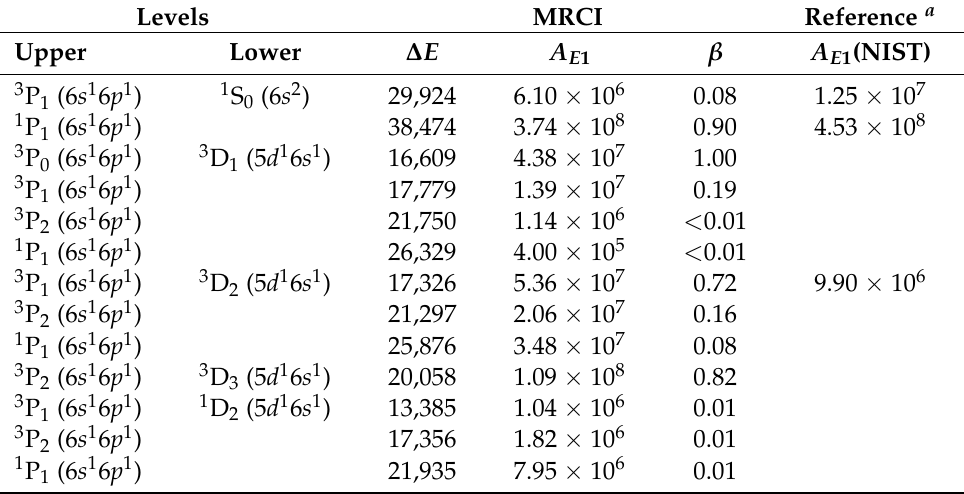
Table 4. Calculated Einstein coefficients A E 1 (in 1/s) and branching ratios β for the electric dipole’s allowed transitions in Lu + , obtained from the MRCI transition dipole moment matrix and the ∆ E (in cm − 1 ) from the complete basis set limit, compared with the reference experimental values.